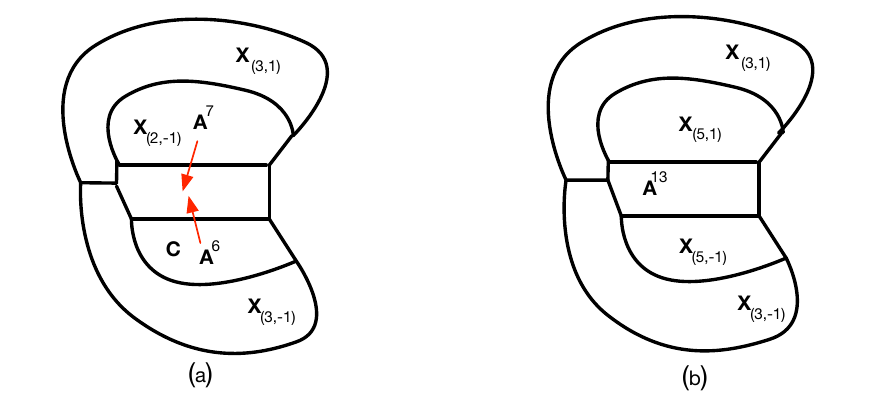
TAS + 13 F Tao diagram. 2